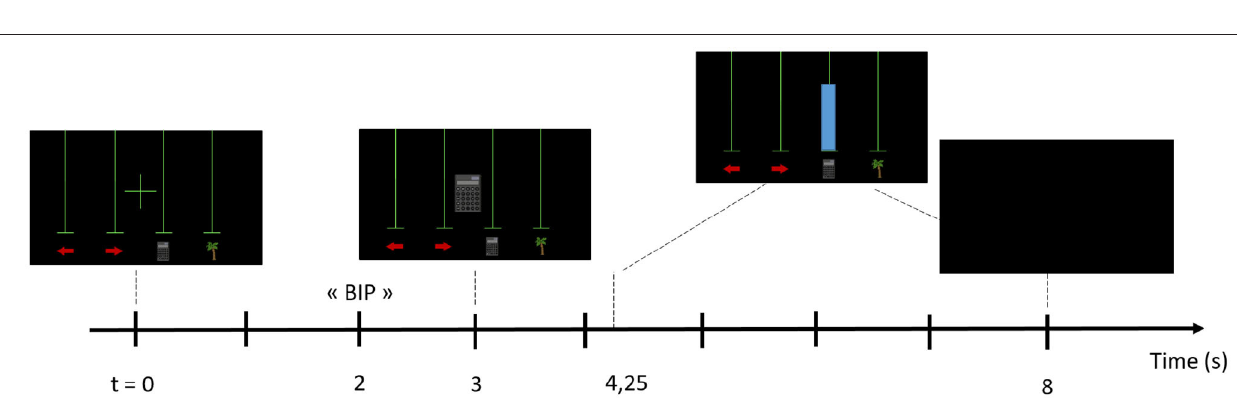
FIGURE 4 | Experimental paradigm used for the 4 classes